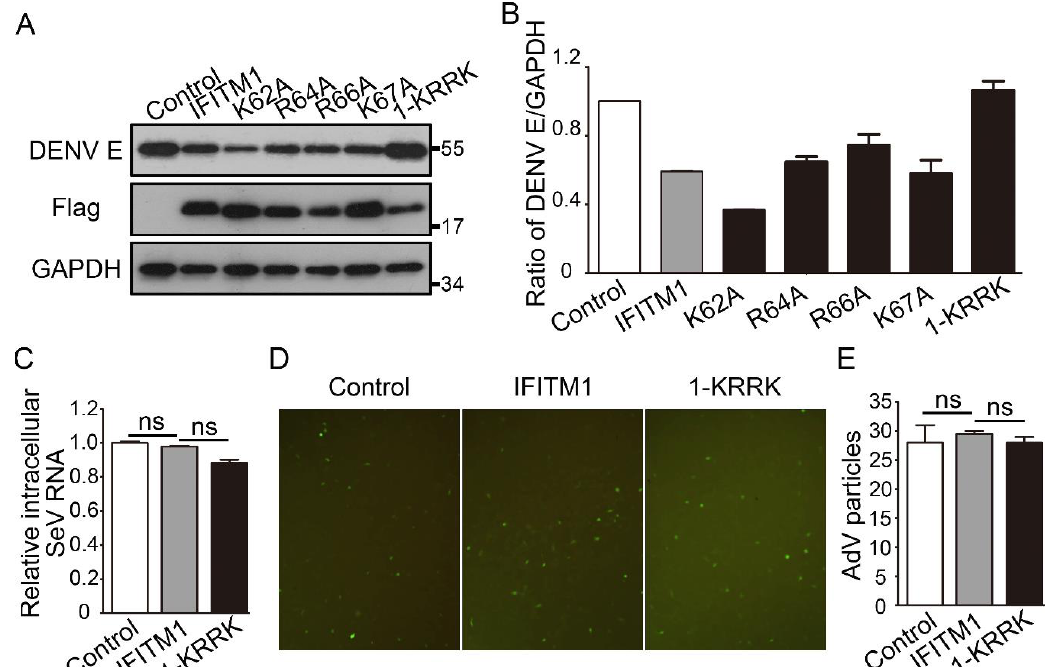
Figure 4. Antiviral functional residues analysis of IFITM1 on dengue virus (DENV), Sendai virus (SeV) and adenovirus (AdV) replications. ( A , B ) The inhibitory effect of IFITM1 and mutants of IFITM1 on DENV replication. pcDNA3.1, pcDNA3.1-Flag-IFITM1 and mutants of pcDNA3.1-Flag-IFITM1 were transfected in Vero cells, respectively. After 24 h, cells were infected with DENV (MOI = 0.1). After 48 h, cells were collected, and the expression level of DENV E protein was analyzed by Western blotting ( A ). Grayscale of figure A was analyzed with Image J software ( B ). ( C ) The effect of IFITM1 and 1-KRRK on SeV replication. pcDNA3.1, pcDNA3.1-Flag-IFITM1 and pcDNA3.1-Flag-1-KRRK were transfected in HEK293T cells, respectively. After 24 h, cells were infected with SeV (MOI = 0.1). After 48 h, cells were collected, and intracellular RNA of SeV was analyzed by qPCR. ( D, E ) The effect of IFITM1 and 1-KRRK on AdV infection in vitro. pcDNA3.1, pcDNA3.1-Flag-IFITM1 and pcDNA3.1-Flag-1-KRRK were transfected in HEK293A cells, respectively. After 24 h, cells were infected with AdV (MOI = 1). After 48 h, the fluorescence of cells was observed using fluorescence microscopy with the magnification of ×200 ( D ). Fluorescence intensity was counted ( E ). ns = no significance.